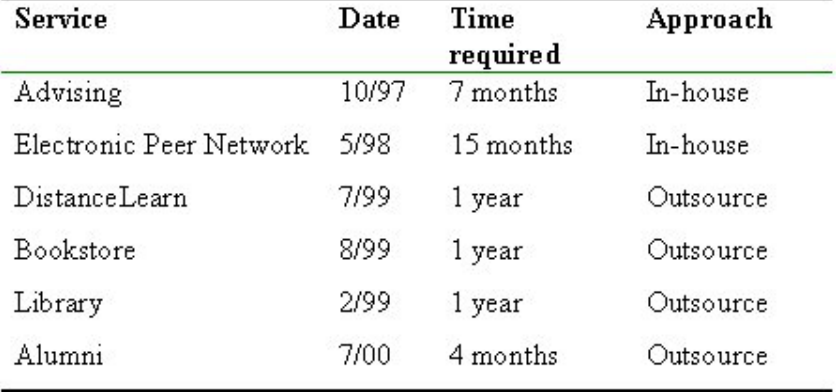
Table 1. Service Conversion Time